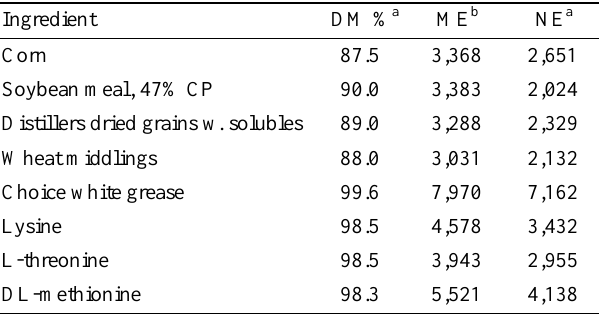
Table 3. Summary of energy values used in formulating